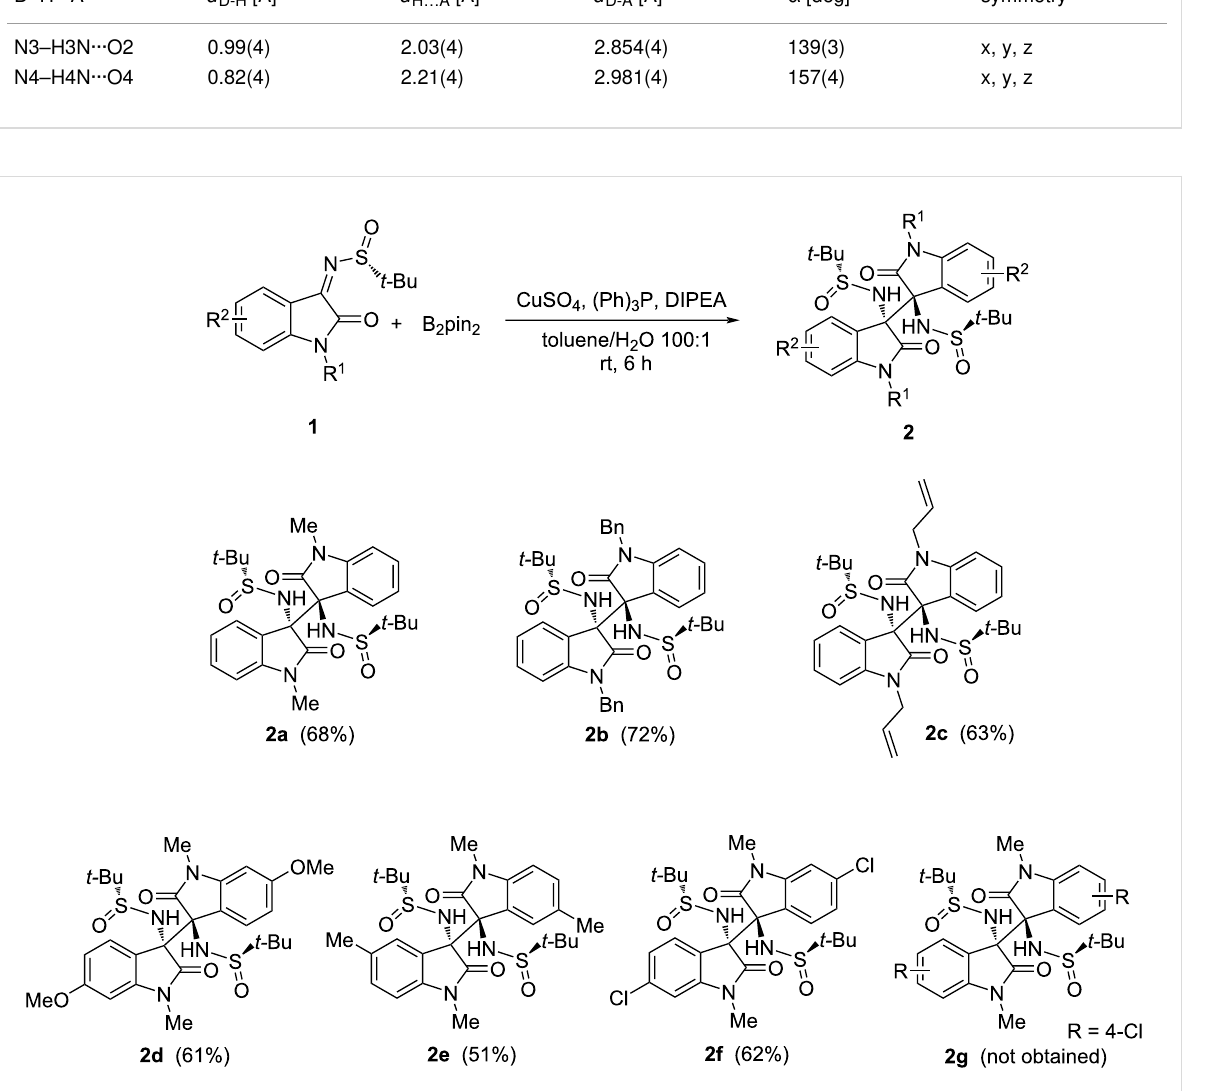
C6 position on the oxindole aromatic ring, such as electron- donating groups (6-OMe, 2d and 5-Me, 2e ) and halogen substit- uents (6-Cl, 2f ), good yields of the corresponding quaternary 1,2-diamines were obtained. Instead, the presence of a substitu- ent at the C4 position (4-Cl, 2g ) hinders the course of the reac- tion, likely due to its spatial proximity with the reaction center, and no homocoupling could be